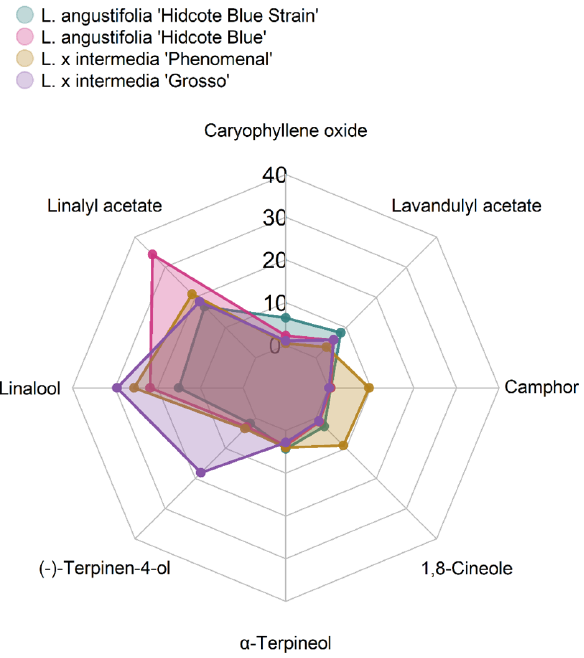
Figure 1. Radar plot presenting the percentage content of the most abundant constituents of the analysed essential oils. The plot was generated using the fmsb 0.7.3 package in R version 4.2.0. Table 2. Identification and content (%) of compounds present in the essential oil obtained from lavender flowers by